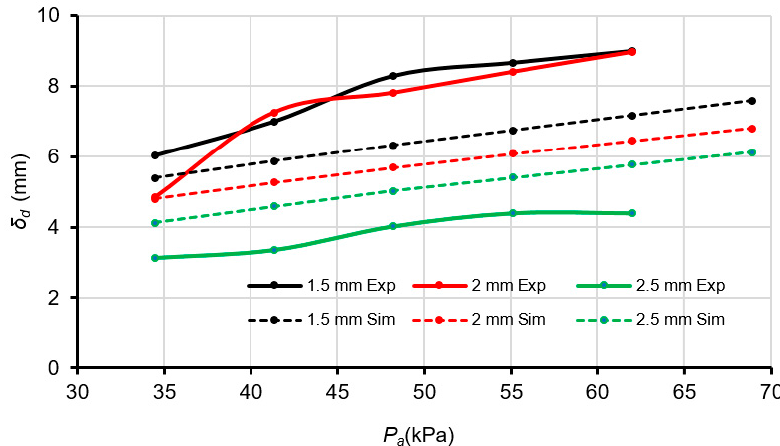
Figure 9. Comparison of experimental and simulation data for wall displacement ( δ d ) at different input pressures ( P a ) .